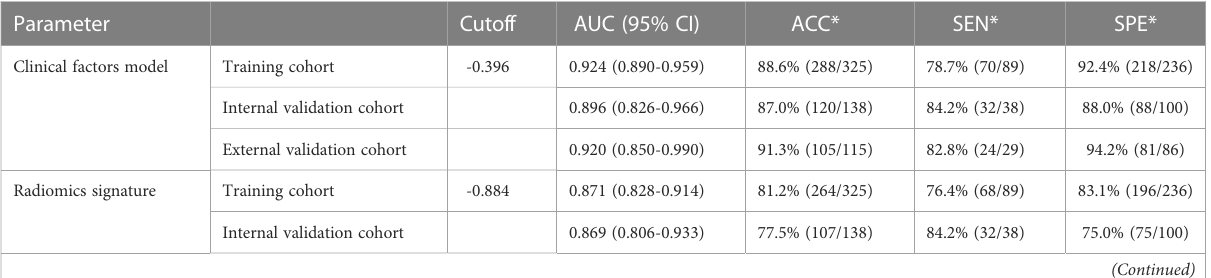
TABLE 4 Results of radiomics nomogram, radiomics signature, and the clinical factors model predictive ability for distinguishing between SDM ccRCC and without SDM